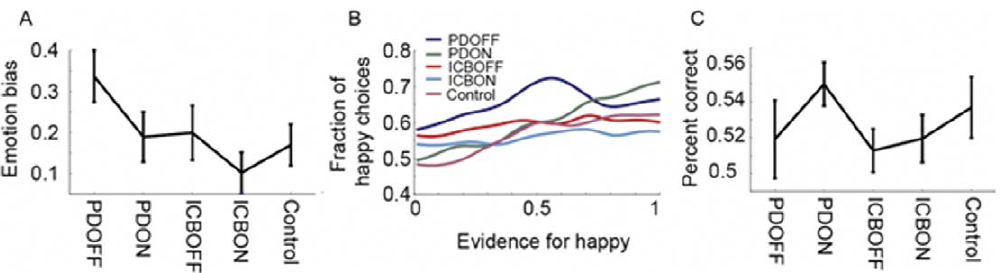
Figure 2. Behavioral results. All error bars are 1 s.e.m. A. Emotion bias for each group. B. Evidence vs. choice curve showing increased selection of happy faces when evidence supports angry face. C. Percent correct for each group.